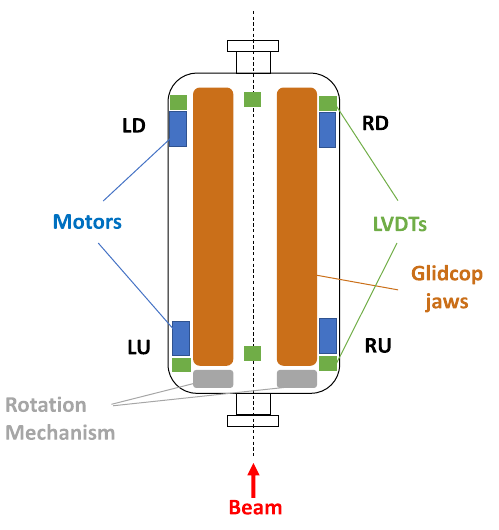
FIG. 3. Rotatable collimator coordinate system, where left- upstream (LU) ¼ corner A, right-upstream (RU) ¼ corner B, left- downstream (LD) ¼ corner C and right-downstream (RD) ¼ corner D.